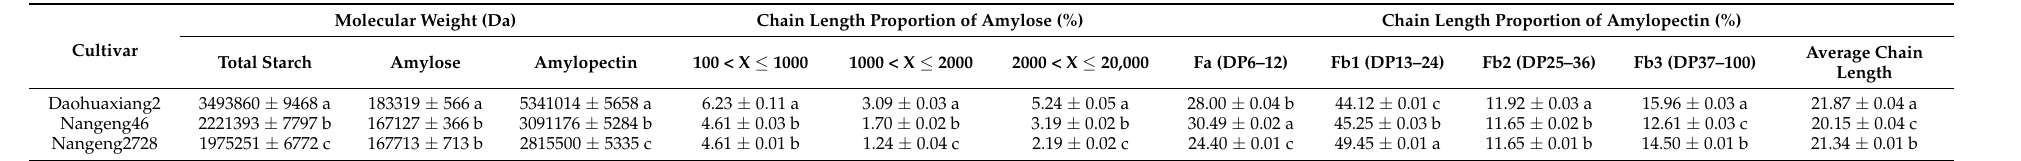
Table 4. Differences of molecular weight and chain length distribution of starch among different japonica